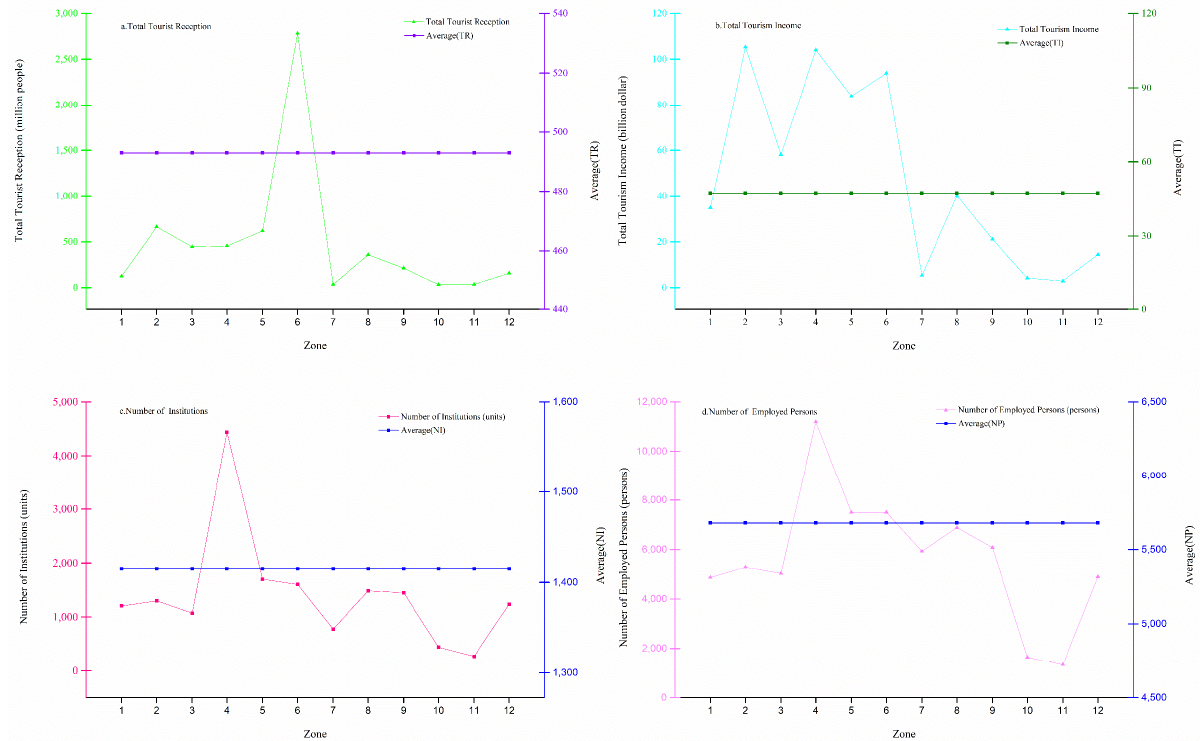
Figure 1. Line charts of tourist arrivals, tourism revenue, mass cultural institutions, and employment in 12 western provinces (regions) in 2020. According to information from the National Bureau of Statistics of China, USD and RMB will be converted according to their average exchange rates in 2020: 1 US dollar to 6.8974 yuan. Zones 1–12 represent Inner Mongolia Autonomous Region (1), Guangxi Zhuang Autonomous Region (2), Chongqing (3), Sichuan Province (4), Guizhou Province (5), Yunnan Province (6), Tibet Autonomous Region (7), Shaanxi Province (8), Gansu Province (9), Qinghai Province (10), Ningxia Hui Autonomous Region (11), and Xinjiang Uygur Autonomous Region (12). ( a ) Total number of tourist receptions in 12 provinces (regions) and average number in western region in 2020; TR represents total number of tourist arrivals (million people). ( b ) For 2020, total tourism revenue of 12 provinces (regions) and average income of western region; TI represents total tourism revenue (billion USD). ( c ) Total tourism revenue of 12 provinces (regions) and average income of western region in 2020; NI represents number of mass cultural institutions. ( d ) Employment at mass cultural institutions in 12 provinces (autonomous regions) in 2020; NP represents number of employed